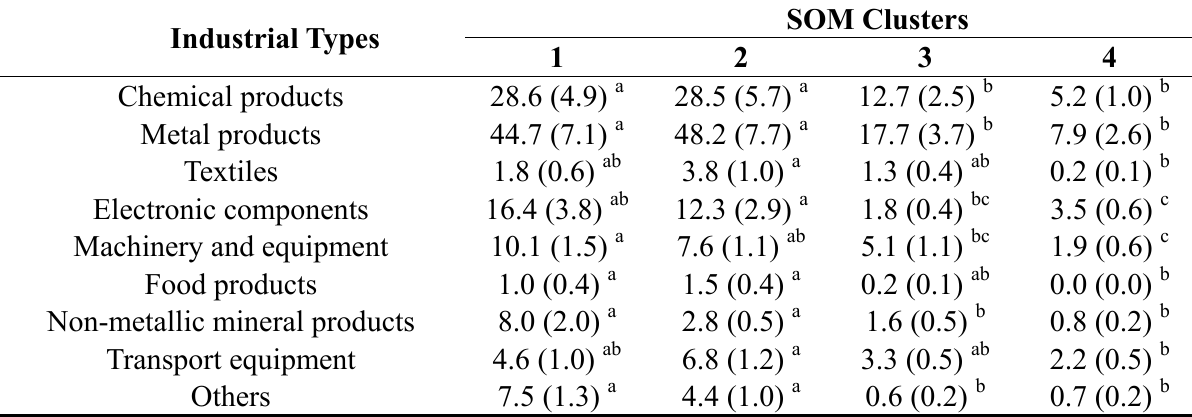
Table 2. Differences in the number of industries (standard error) at different industry types at different clusters defined in SOM. Different letters indicate significant differences between the clusters based on Dunn’s test after a Kruskal–Wallis test ( p <